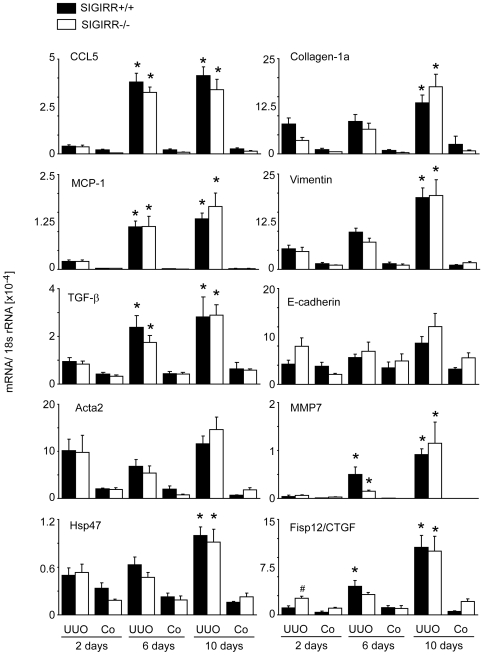
Renal mRNA expression in wildtype and Sigirr-deficient kidneys after after UUO.Wildtype (black bars) and Sigirr-deficient mice (white bars) underwent UUO and kidneys were harvested at different time points after surgery as indicated. mRNA expression levels were determined by real-time RT-PCR and related to the respective 18S rRNA expression. Data are expressed as means ± SD. # p<0.05 versus wildtype of the same time point, * p<0.05 versus time point day 2.